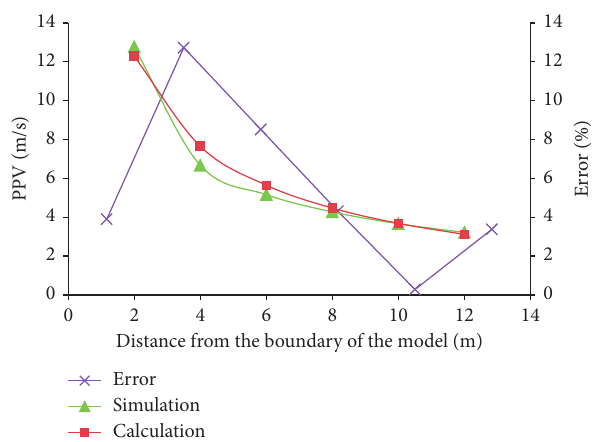
Figure 8: Error analysis of PPV with increasing distance.